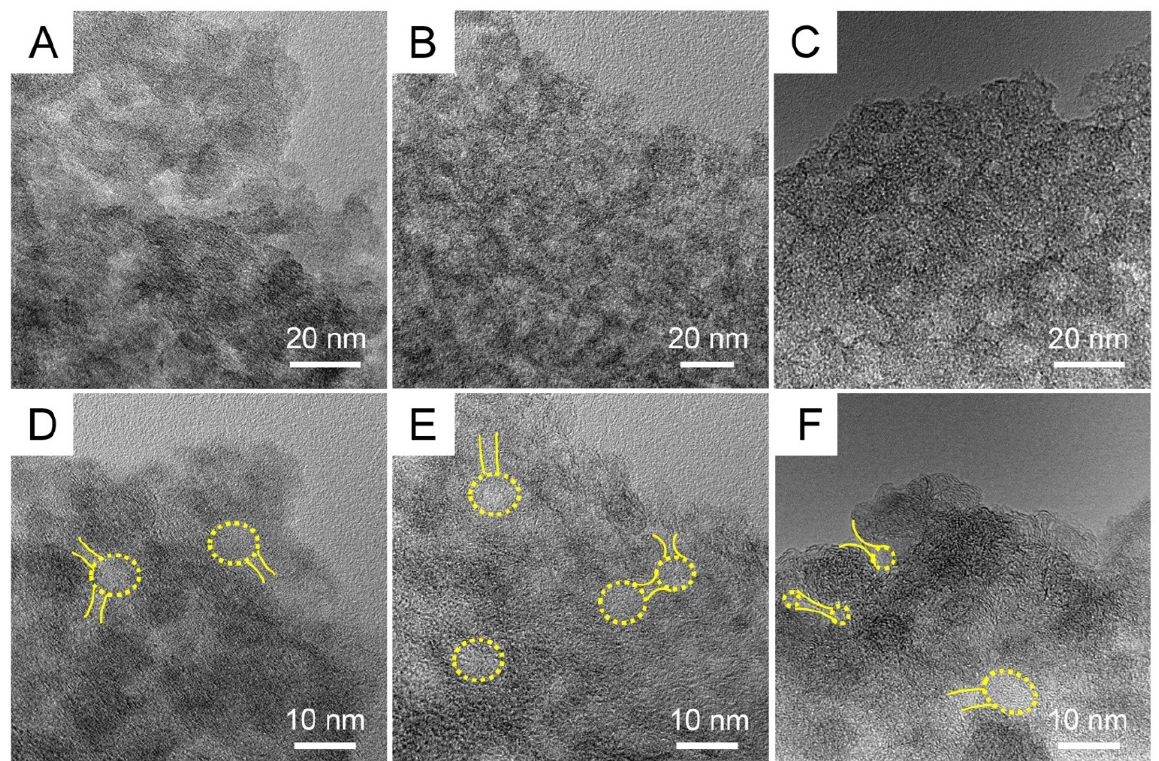
Figure 4. TEM images of ( A , D ) NDCX, ( B , E ) P-NDCX-1.0, and ( C , F ) S-NDCX-1.0 with different magnification.